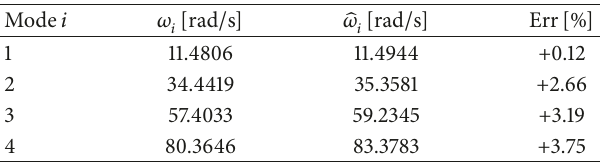
Table 13: Modal parameters estimated on the undamaged con- tinuous shear-deflecting structure by using the RWS-TSVD-based algorithm.